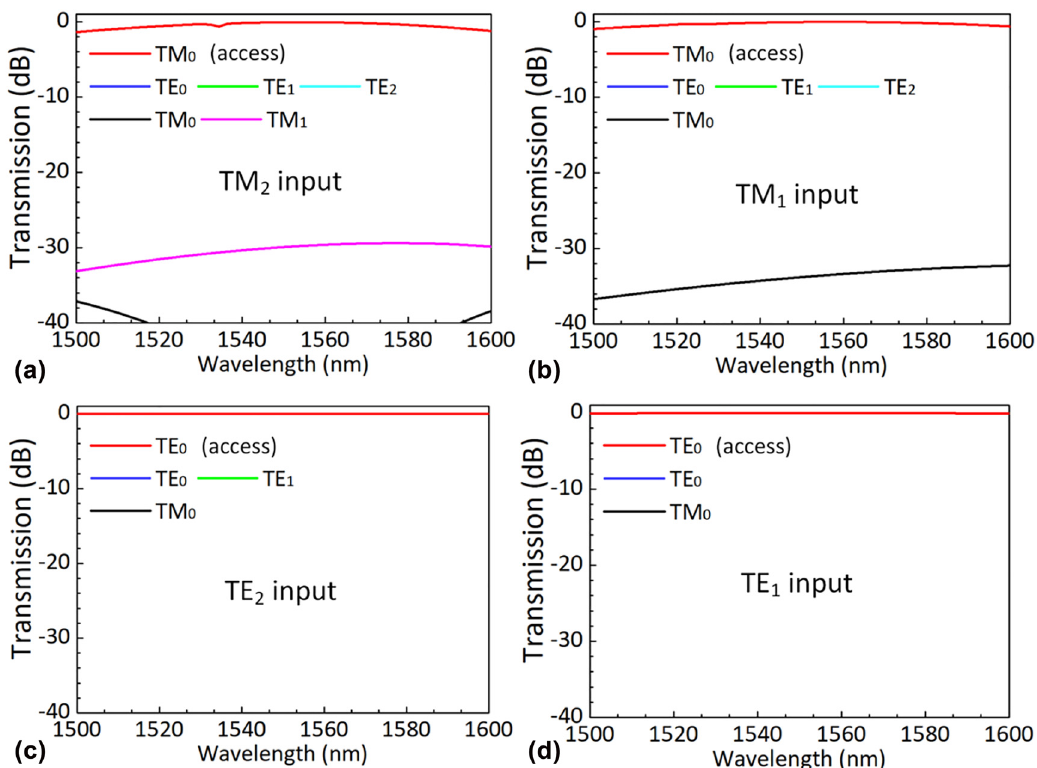
(a), TM (b), TE (c), and TE (d) modes in the corresponding coupler in the wavelength 2 1 2 1